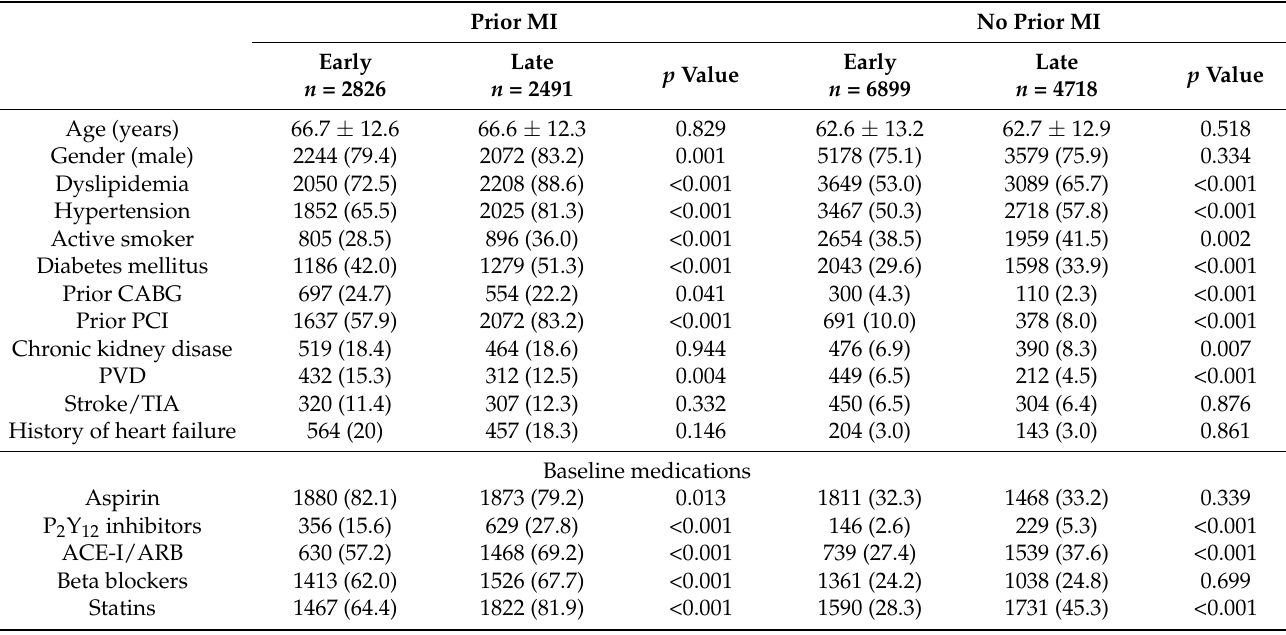
Table 1. Baseline characteristics of patients with and without prior MI, compared between time periods (early 2000–2008 vs. late 2010–2018).